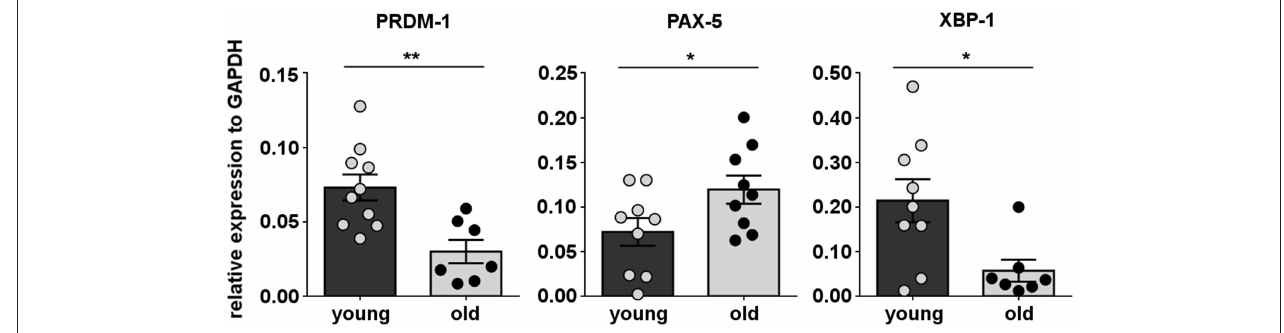
FIGURE 3 | Human B-1 cell expression of secretory genes changes with advancing age. B-1 cells from PBMCs were sort-purified and analyzed by RT-PCR for gene expression. The panels represent the relative expression of transcription factors related with B-cell secretory phenotype for 9–10 young and 7–8 old donors, normalized to GAPDH. * p < 0.05, ** p < 0.01 by Mann–Whitney U -test, bars are mean and standard error of the mean